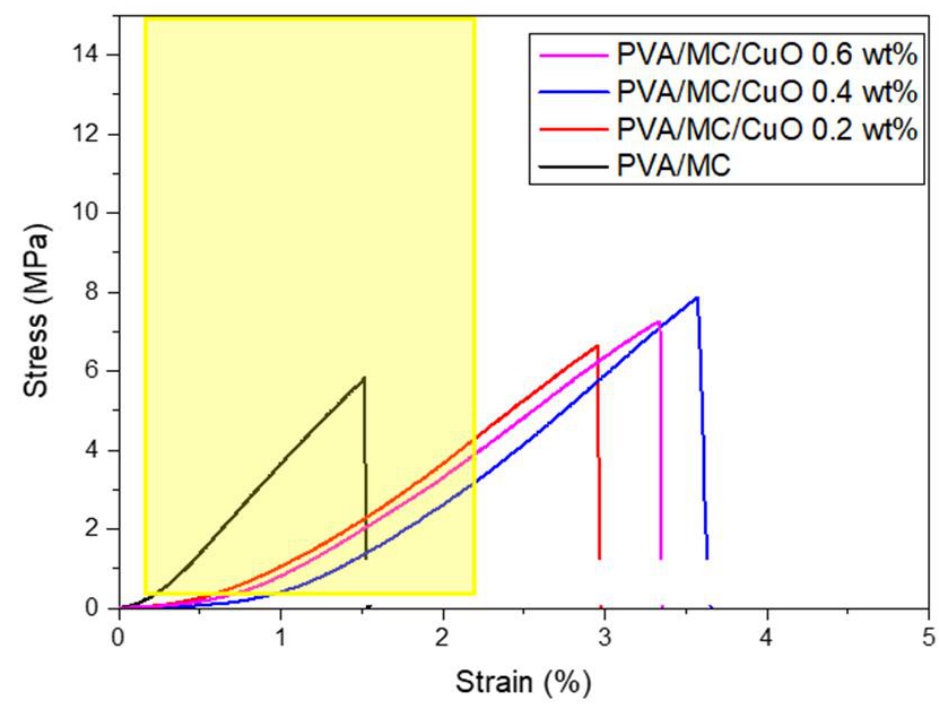
Figure 5. Stress – strain diagram of the PVA/MC/CuO 0.2 wt.%, PVA/MC/CuO 0.4 wt.%, Figure 5. Stress–strain diagram of the PVA/MC/CuO 0.2 wt.%, PVA/MC/CuO 0.4 wt.%, and and PVA/MC/CuO 0.6 wt.% nanofibers. PVA/MC/CuO 0.6 wt.%